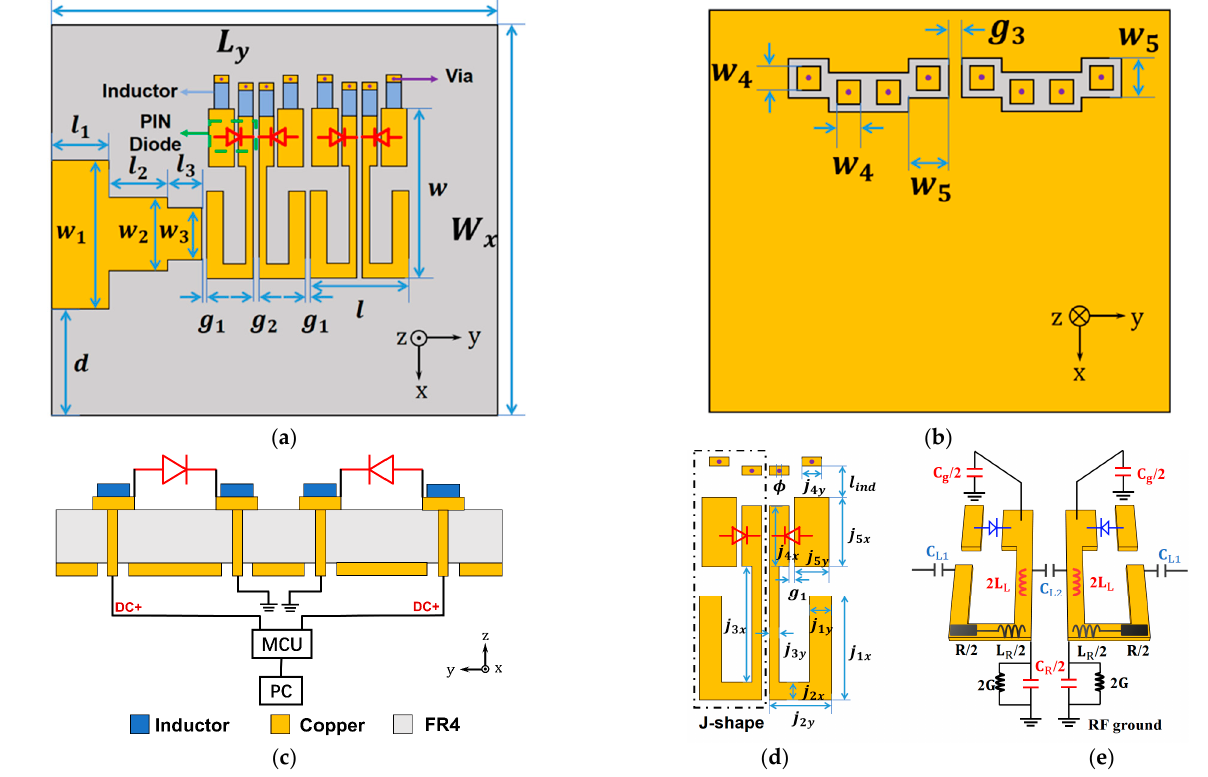
Figure 4. Design model of the proposed MTM antenna: ( a ) top view, ( b ) bottom view, ( c ) side view, and ( d ) unit design with dimensions (mm): W x = 26, L y = 34.5, l 1 = 3.5, w 1 = 9, l 2 = 6.5, w 2 = 4, l 3 = 2, w 3 = 2.7, w = 9.1, l = 5.2, g 1 = 0.2, g 2 = 0.3, d = 7.85, j 1x = 4.7, j 1y = 0.9, j 2x = 0.8, j 2y = 2.5, j 3x = 5.2, j 3y = 0.4, j 4x = 2.7, j 4y = 0.8, j 5x = 3.1, j 5y = 1.4, g 4 = 0.4, l ind = 1.4, Φ = 0.2, w 4 = 0.8, w 5 = 1.4; ( e ) the equivalent CRLH circuit model of unit cell.